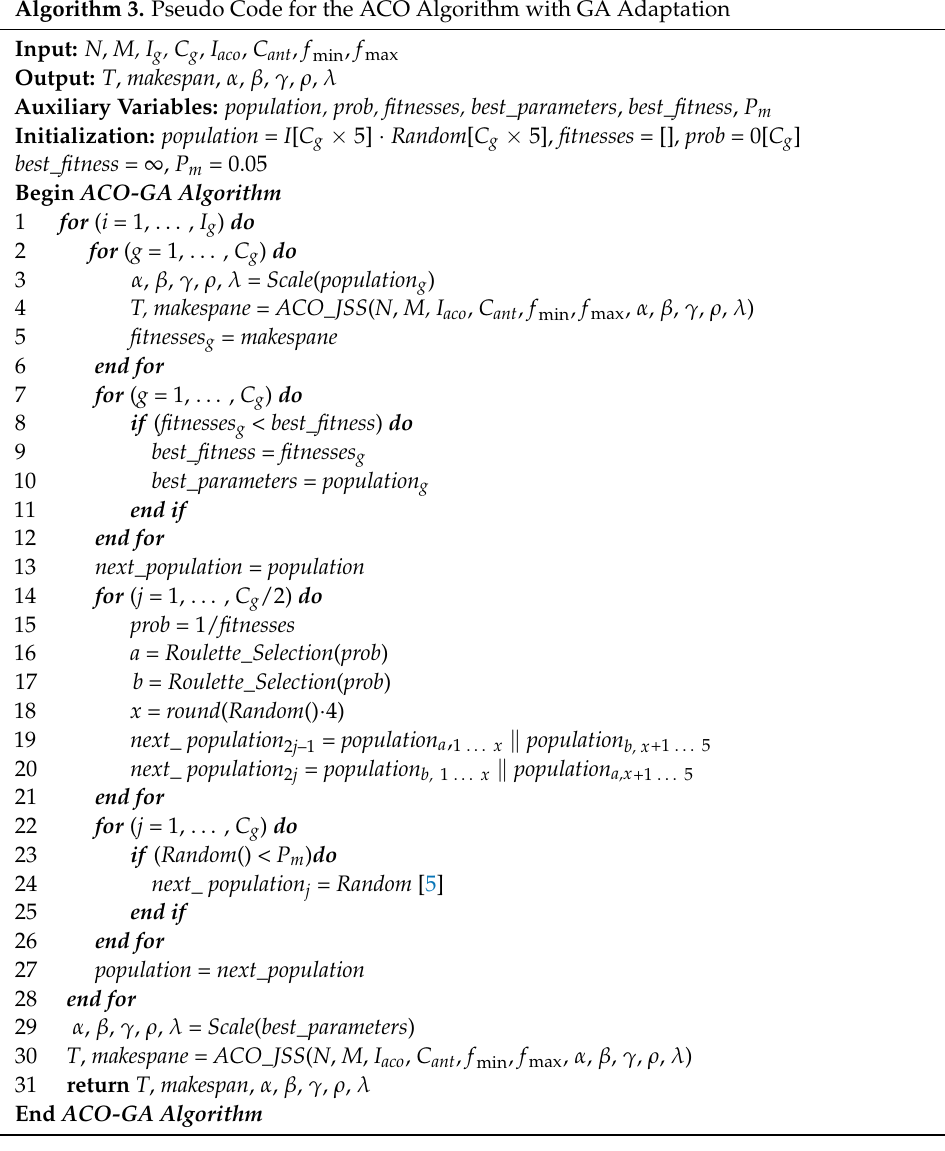
Algorithm 3. Pseudo Code for the ACO Algorithm with GA